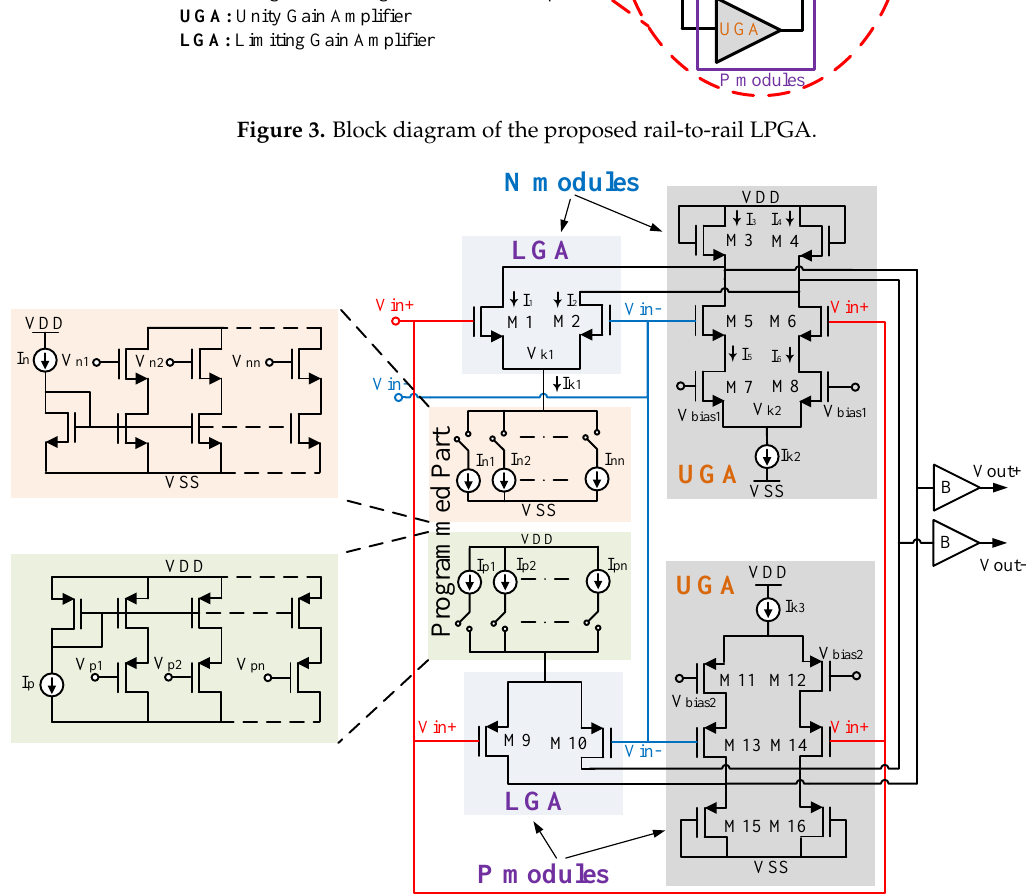
Figure 4. Circuit schematic of one dual-gain